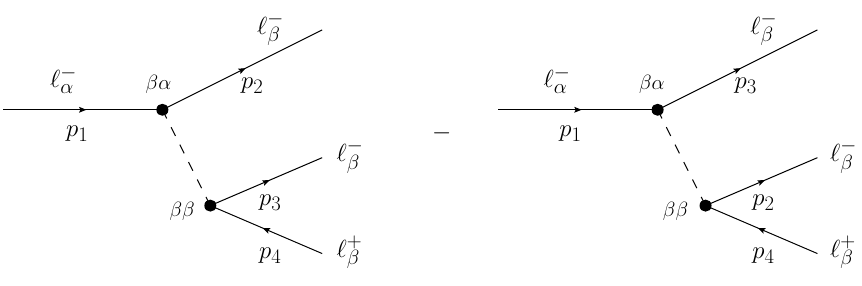
→ ‘ − ‘ − ‘ + described by α β β β